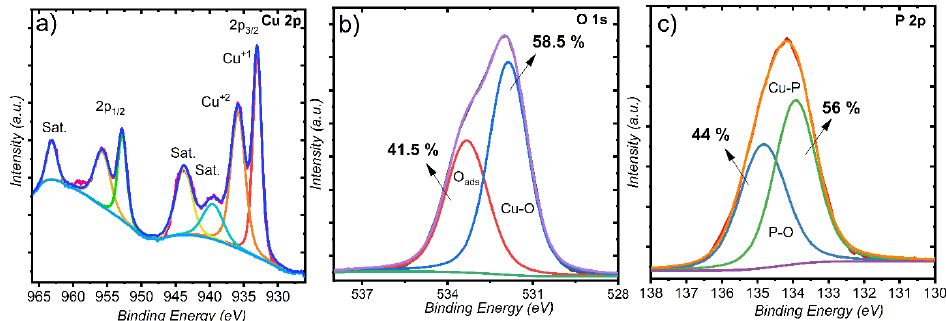
Figure 2. Core-level high-resolution XPS spectra of ( a ) Cu 2p; ( b ) O 1s due to the existence of CuO; and ( c ) P 2p due to the presence of Cu 3 P.